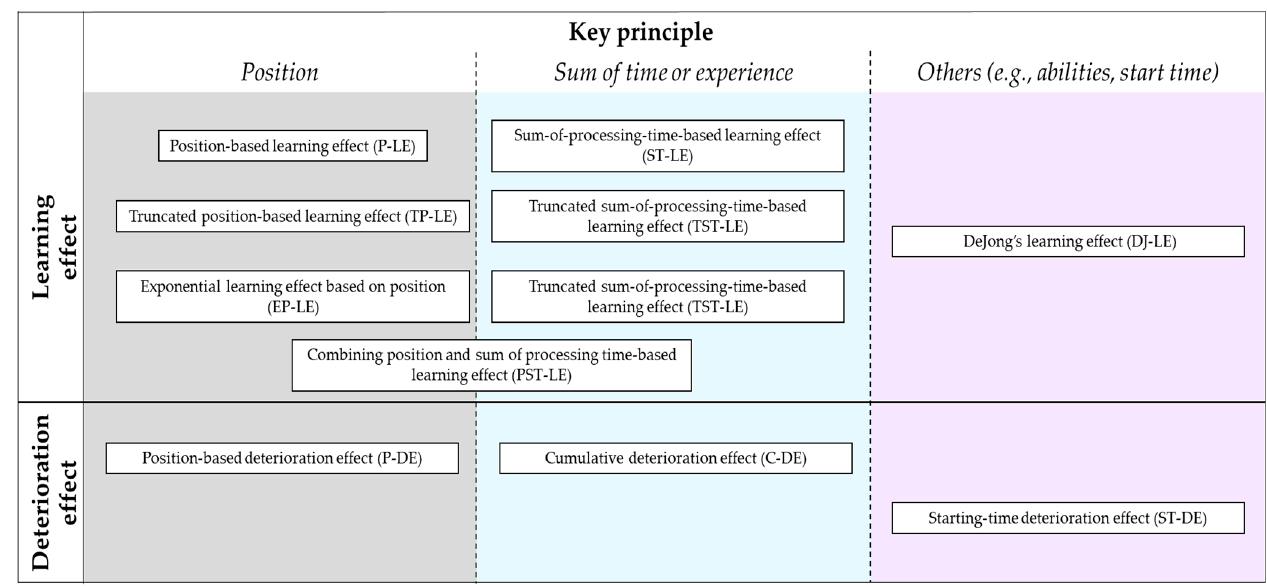
Figure 7. Taxonomy visualization .